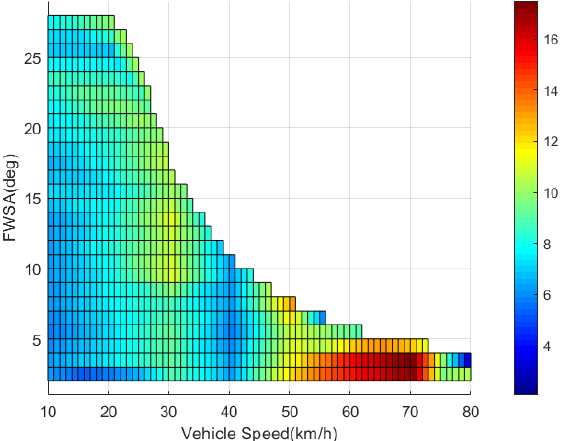
Figure 8. Energy-saving effect based on motor working point.